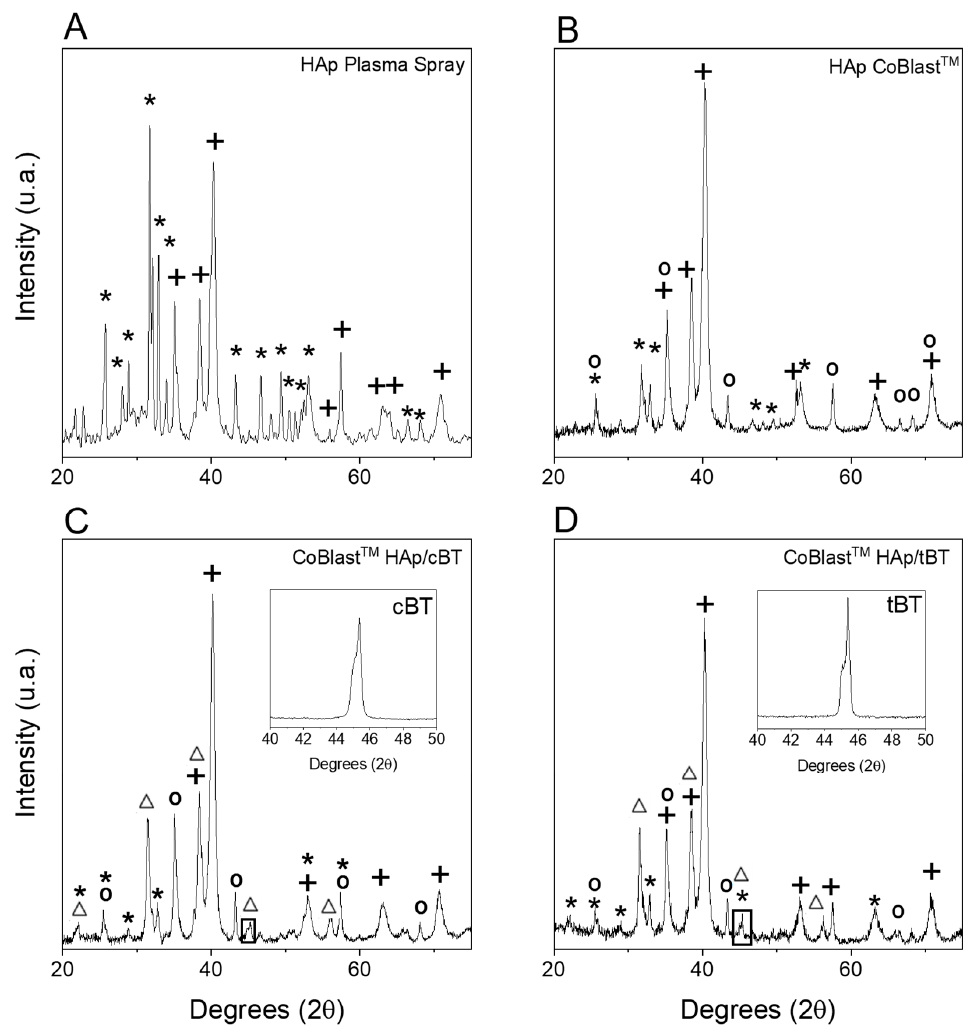
Figure 2. XRD analysis of the di ff erent coatings produced: HAp by plasma spray ( A ) and by CoBlast TM of HAp ( B ), 80%/20% HAp/BaTiO 3 cubic nanopowders ( C ), 80%/20% of HAp/BaTiO 3 tetragonal micropowders ( D ). +—Ti-6Al-4V; *—HAp; o—Al 2 O 3 ; Δ —BT.